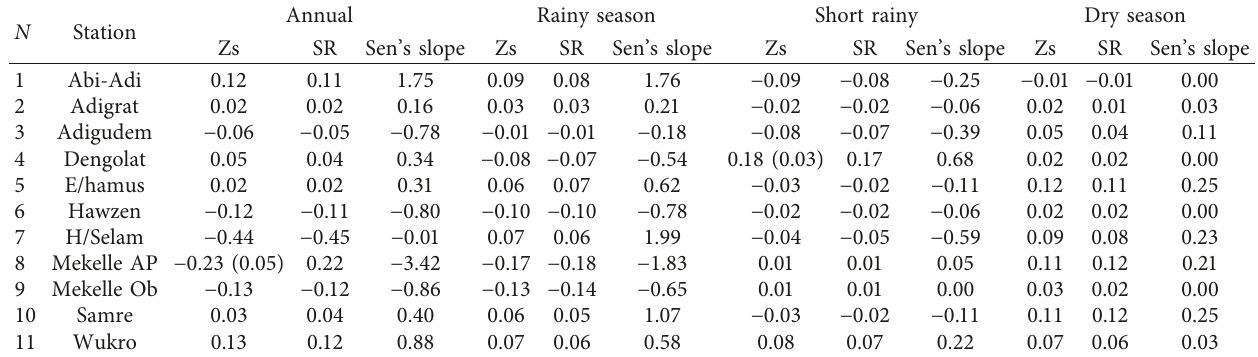
Table 4: Summary of the rainfall trend test using Mann–Kendall, SR, and Sen’s slope.